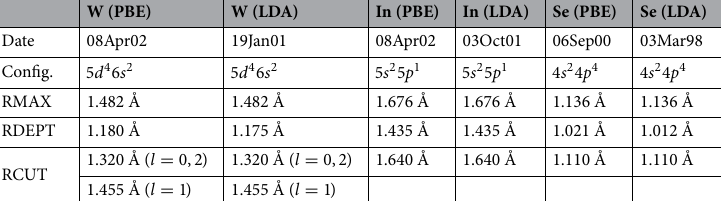
W (PBE) W (LDA) In (PBE) In (LDA) Se (PBE) Se (LDA)